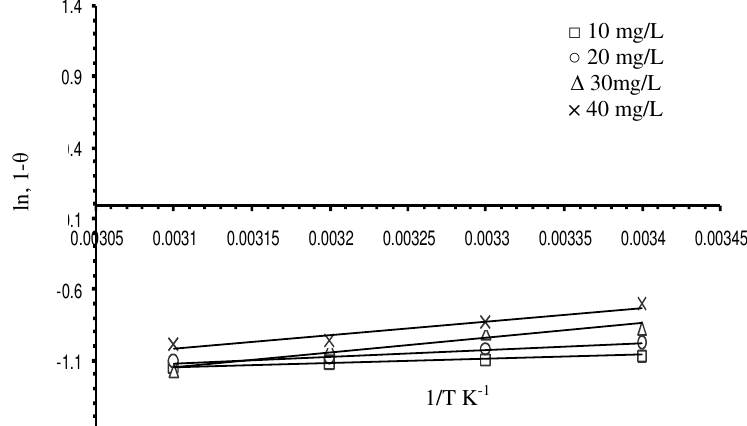
Figure 2. Plot of ln(1- θ ) vs. reciprocal temperature for the adsorption of Cr(VI) onto